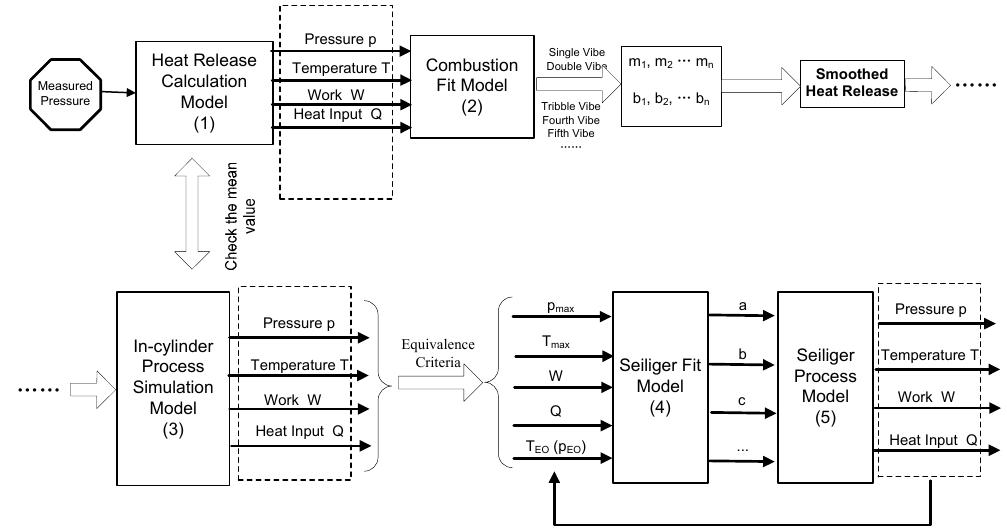
Table 2. Seiliger process definition and parameters.